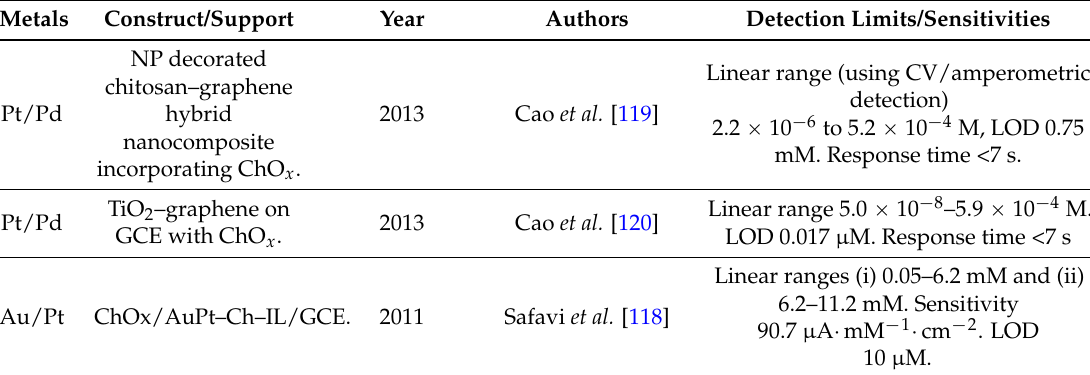
Table 5. Metals and constructs used for sensors designed for cholesterol sensing.